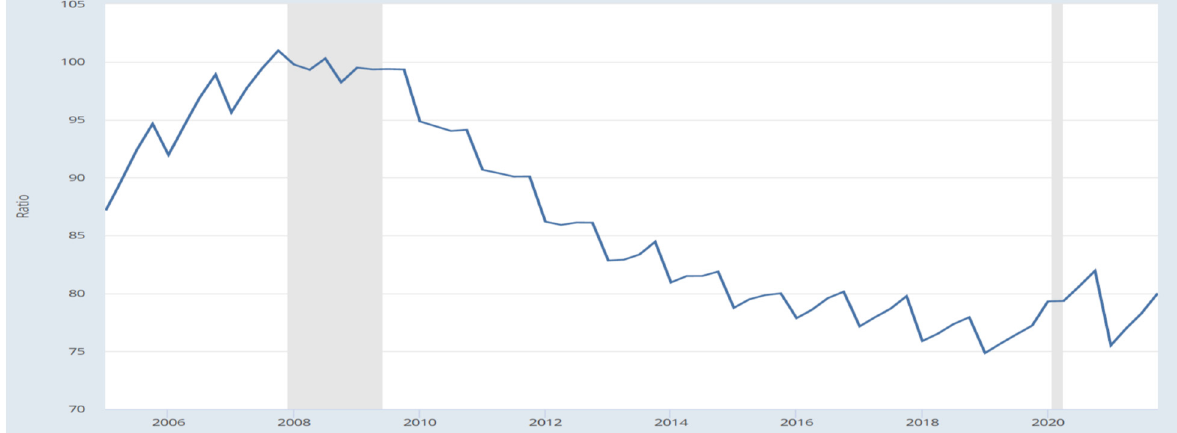
Figure 9. Household Debt as a Percent of GDP. Source: International Monetary Fund.